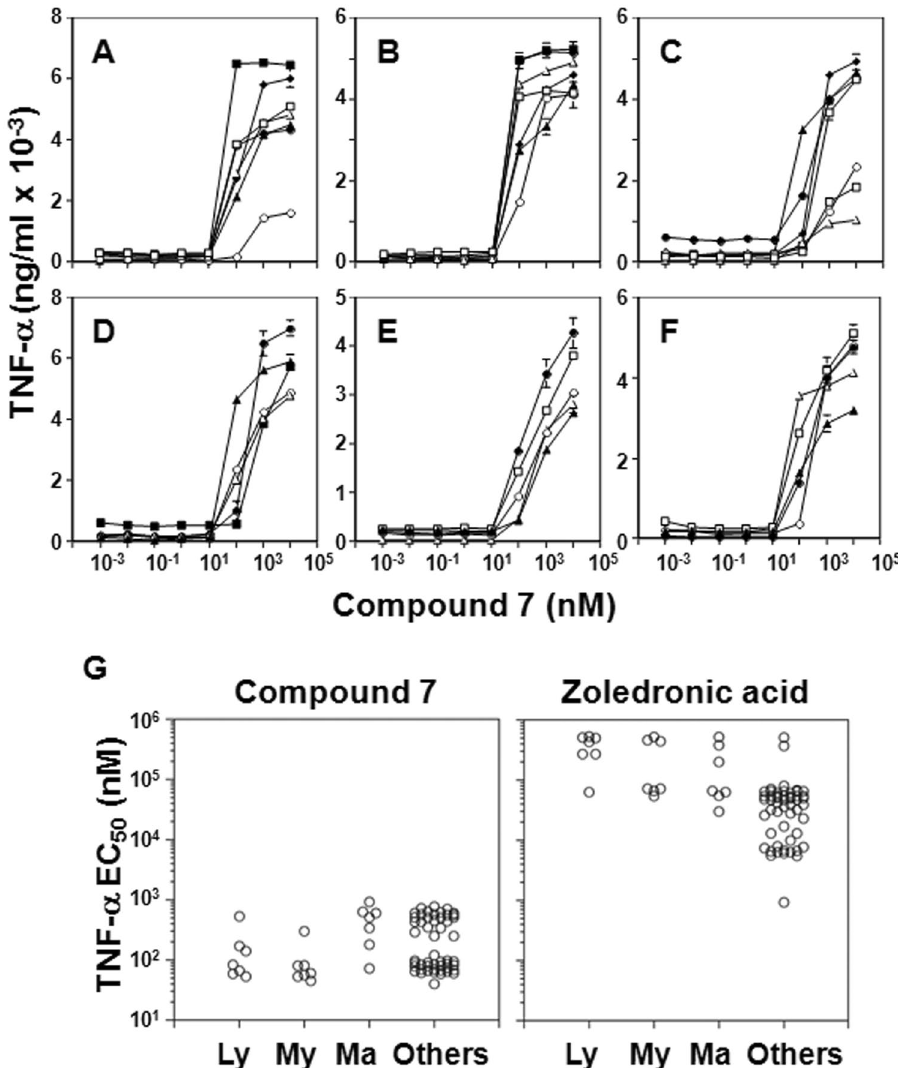
Figure 3. Stimulation of TNF- α secretion from γδ T cells by tumor cells pretreated with compound 7. ( A – F ) Stimulation of TNF- α production by γδ T cells in response to compound 7 pretreatment of various tumor cell lines; ( A ) lymphomas, ▫ MOLT-3, ∆ PEER, ⚪ C1R, ⬧ J.RT3-T3.5, ▪ Raji, ▴ RAMOS-RA1, ⚫ MOLT-4; ( B ) myeloid leukemias, ▫ HL60, ∆ U937, ⚪ THP-1, ⬧ SCC-3, ▪ P31/FUJ, ▴ K562, ⚫ NOMO-1; ( C ) mammary carcinomas, ▫ YMB-1-E, ∆ MRK-nu-1, ○ HMC-1-8, ⬧ MCF-7, ▪ MDA-MB-231, ▴ T-47D, ⚫ SK-BR-3; ( D ) renal cell carcinomas, ▴ 786-0, ∆ VMRC-RCZ, ⚫ UOK121, ⚪ Caki-1, ▪ A-704; ( E ) pancreatic carcinomas, ⚫ BXPC-3, ▴ KP4-1, ⚪ KP4-2, ▫ KP4-3, ∆ MiaPaCa2; ( F ) other tumor cells, ⚫ TGB24TKB cholangiocell